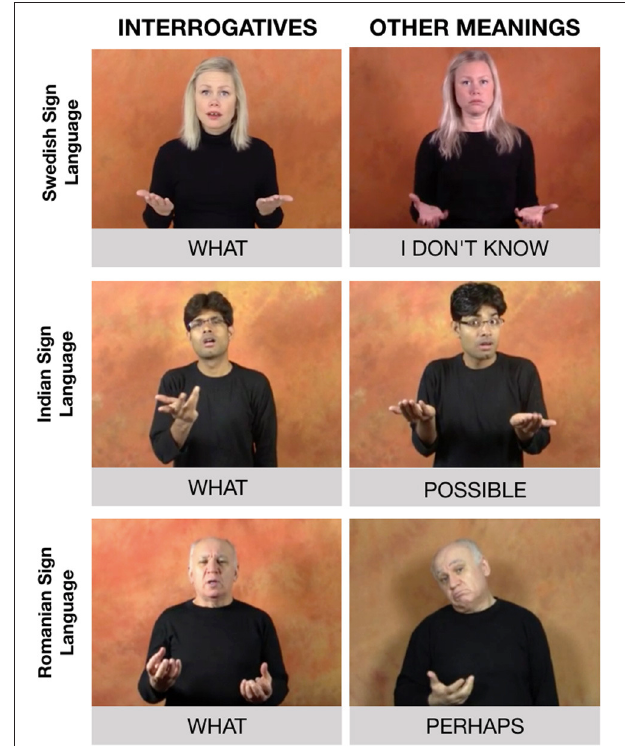
FIGURE 3 | Examples of signs involving palm-up forms, taken from three unrelated sign languages. Signs in the left column have interrogative meanings; signs in the right column have other epistemic meanings, such as absence of knowledge. All images, glosses, and language classifications are from the “Spread the Sign” dictionary (https://www.spreadthesign.com). Images reproduced with